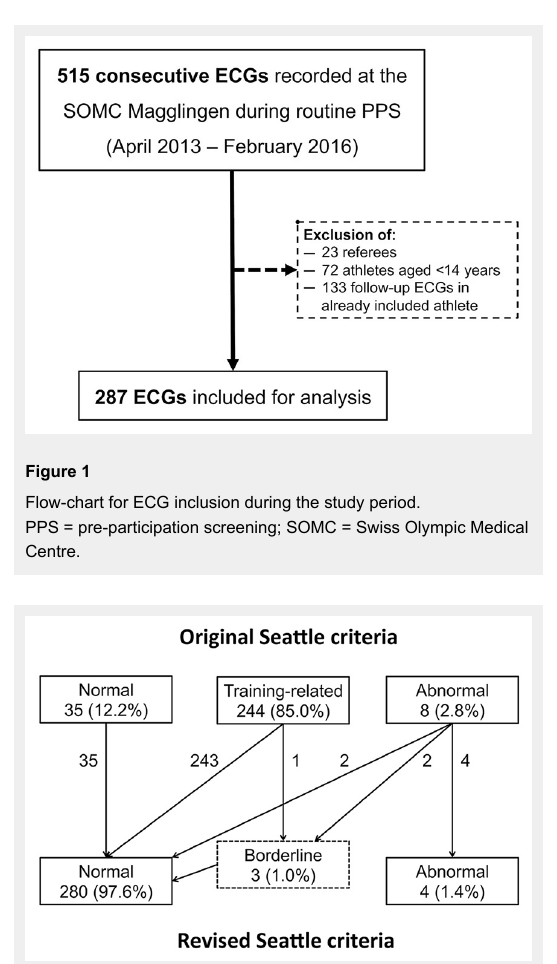
ECGs were classified as “normal”, 244 (85.0%) as “training-related” and 8 (2.8%) as “abnormal”. One athlete showed right precordial TWI, two athletes inferolateral